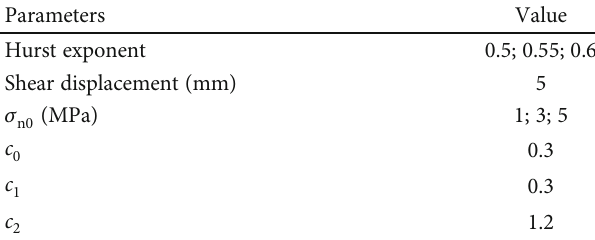
Figure 1: Generated self-a ffi ne fracture surfaces with H = 0 : 5 , 0.55, and 0.6. Table 1: Related parameters for numerical